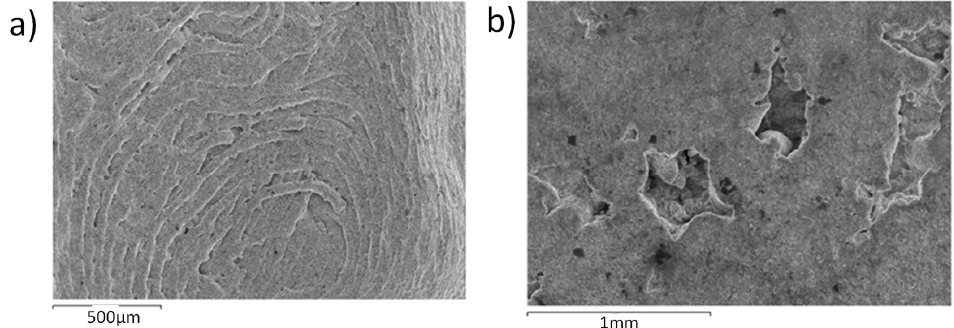
Figure 11. Surface defects of laser-sintered samples observed by SEM: ( a ) welding seams produced along the sintering path, and ( b ) Aligned microporosity with particles inside.